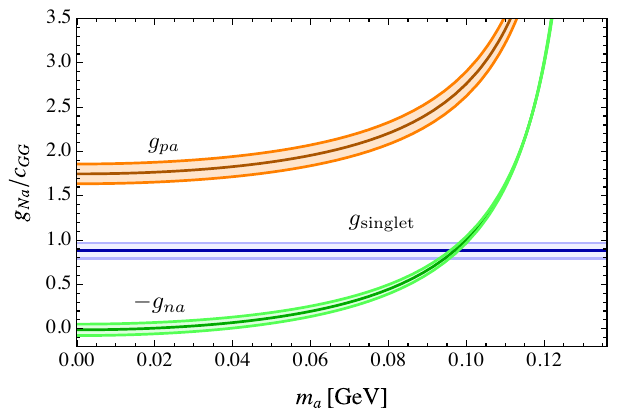
Figure 5 . Mass dependence of ALP-nucleon couplings for the proton (orange), the neutron (green), and an iso-singlet nucleus with coupling g coupling c . The ALP couplings to quarks are set to zero ( c GG expectation value of the nucleon spin